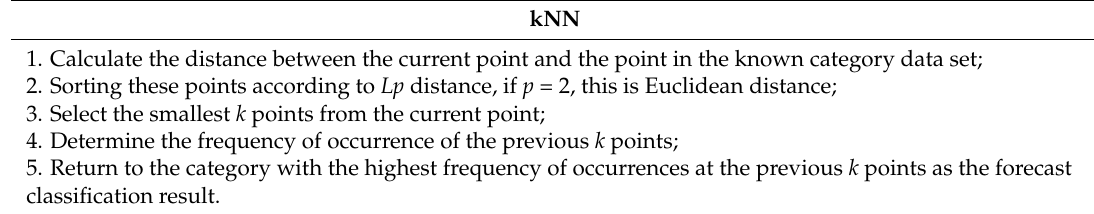
Table 1. The flowchart of k-Nearest Neighbors (kNN)